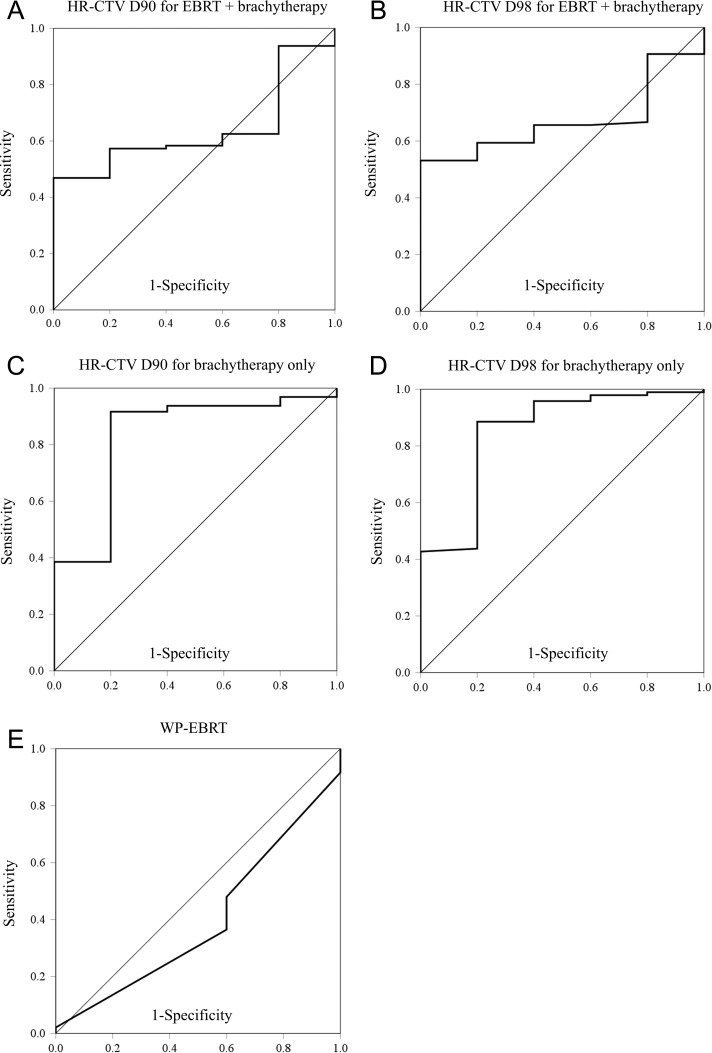
Receiver operator characteristic curve related to local control (LC) based on the sensitivity and specificity of the HR-CTV D90 for external beam radiotherapy (EBRT) and brachytherapy combined (A), HR-CTV D98 for EBRT and brachytherapy combined (B), HR-CTV D90 for brachytherapy sessions only (C), and HR-CTV D98 for brachytherapy sessions only (D).